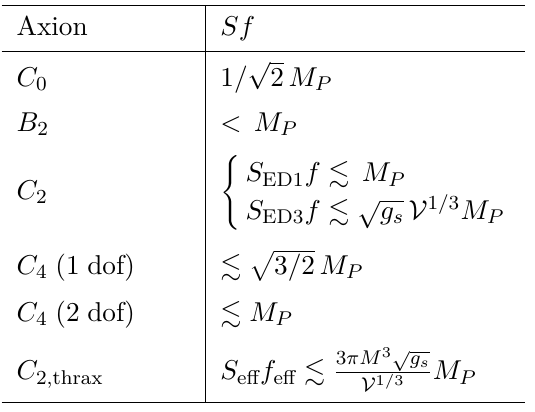
Table 1 . Bounds on Sf for different classes of closed string axions. These results arise from the study of simple extra-dimensions geometries. Further details are contained in appendix